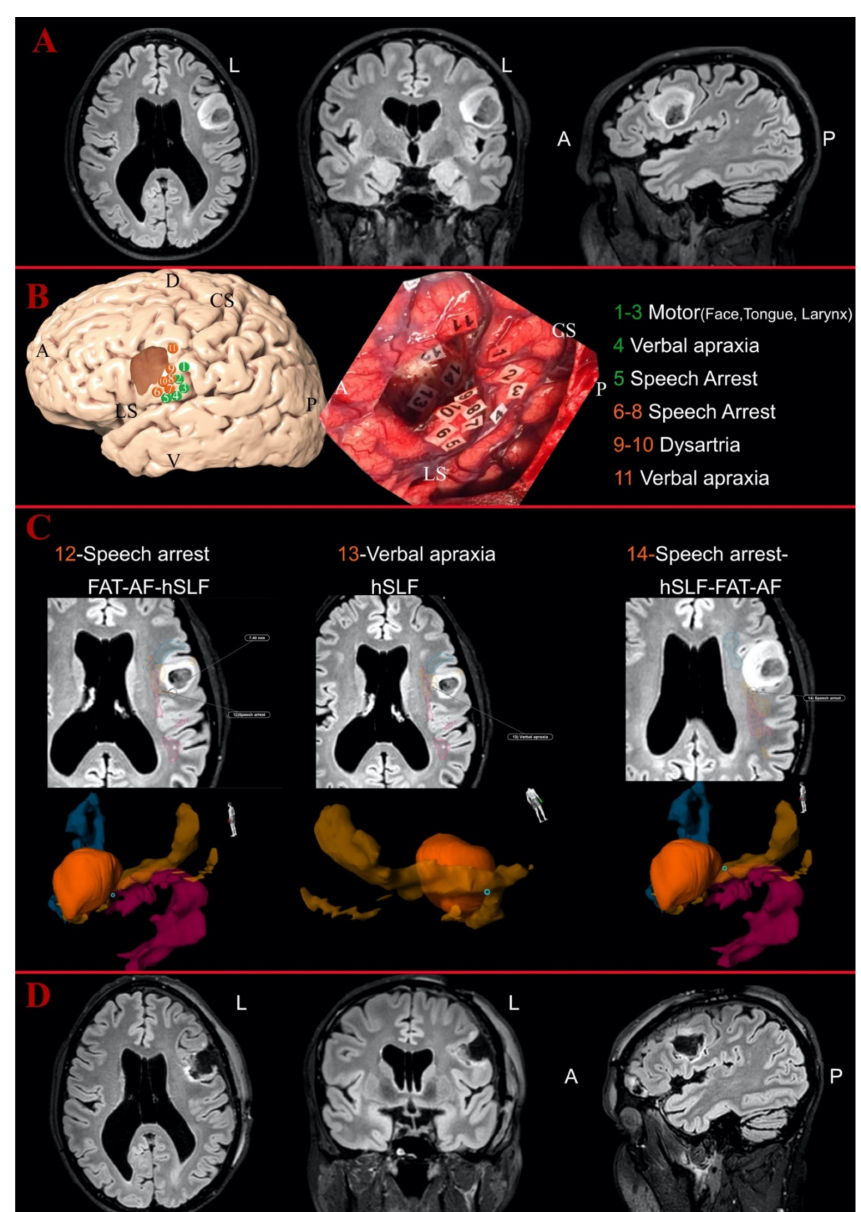
Figure 3. Illustrative case of fronto-opercular Astrocytoma Grade II on the left side: ( A ) the preop- erative MR images of FLAIR sequences in axial, coronal and sagittal perspective; and ( B ) the 3D reconstruction of the left hemisphere with the tumor (in dark orange) and the distribution of the cortical eloquent spots in the upper part. The middle part shows the intraoperative picture after the mapping and the resection showing the distribution of the cortical and subcortical eloquent spots, listed in the lower part of the image. The spots are listed in green if considered outside the tumor area, in orange if peritumoral (<10 mm) or in red if considered intratumoral. ( C ) The postoperative analysis of the subcortical spots displayed in axial slices with the distance from the related white matter bundles and the 3D reconstruction of the points-tumor and white matter reconstructions. Horizontal segment of superior longitudinal fasciculus (orange), FAT (blue) and AF (magenta). Spot Numbers 12–14 were detected as peritumoral eloquent spots, eliciting, respectively, speech arrest, verbal apraxia and speech arrest, but they were not inside the vSLF reconstruction. Spot Number 5 (elicited sematic paraphasia) was detected as peritumoral and again not inside the course of the IFOF according to the 3D tractography reconstruction. The position of Number 12 did not match any of the related white matter bundles for speech arrest, while Numbers 13 and 14 were located along